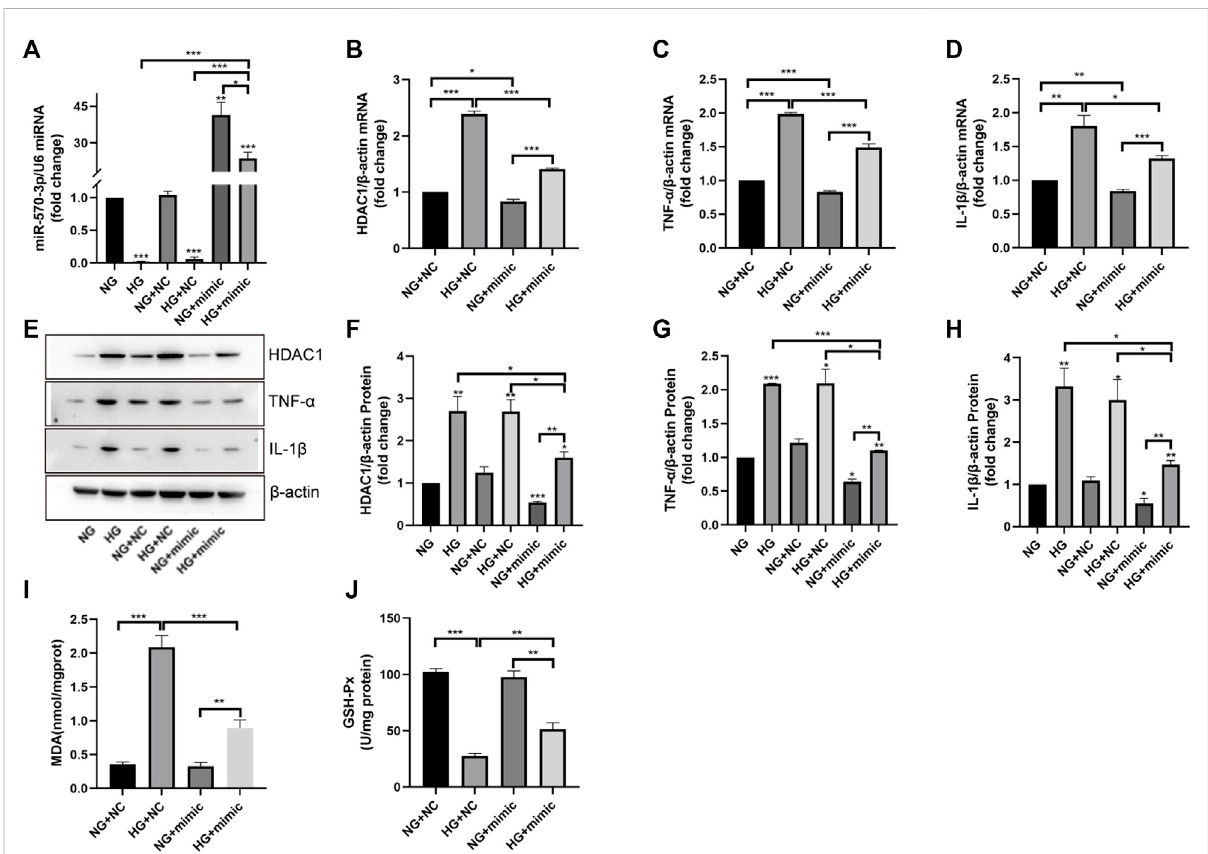
FIGURE 7 OverexpressionofmiR-570-3pinhibitedHDAC1 expressionandin fl ammatoryinjuryinHUVECcells. (A) .The expression ofmiR-570-3pmiRNA in HUVEC cells transfected with miR-570-3p NC or miR-570-3p mimics. (B – D) . The expression of HDAC1 mRNA, TNF- α mRNA, and IL-1 β mRNA in HUVEC cells transfected with miR-570-3p NC or miR-570-3p mimics. (E – H) . Western blotting analysis of HDAC1, TNF- α , and IL-1 β protein expression levels in HUVEC cells transfected with miR-570-3p NC or miR-570-3p mimics. Gray value of western blotting. (I) . Content of MDA. (J) . Activity of GSH-Px. Values are mean ± SEM. n = 3 in each group. * p < 0.05, ** p < 0.01, *** p <